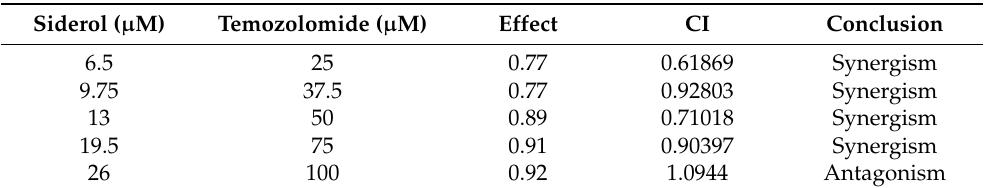
Table 3. Assessment of combinatorial effect of siderol and TMZ in U87 cells. Concentrations of each substance, the effect (% mortality) and CI of each combination are represented. Data were determined by CompuSyn software. CI allows quantitative determination of drug interactions, where CI < 1, =1 and >1 indicates synergism, additive effect and antagonism, respectively. Siderol ( μ M) Temozolomide ( μ M)